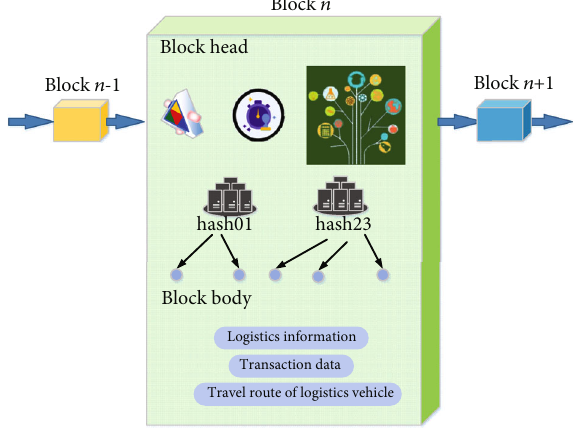
Figure 2: Blockchain structure.